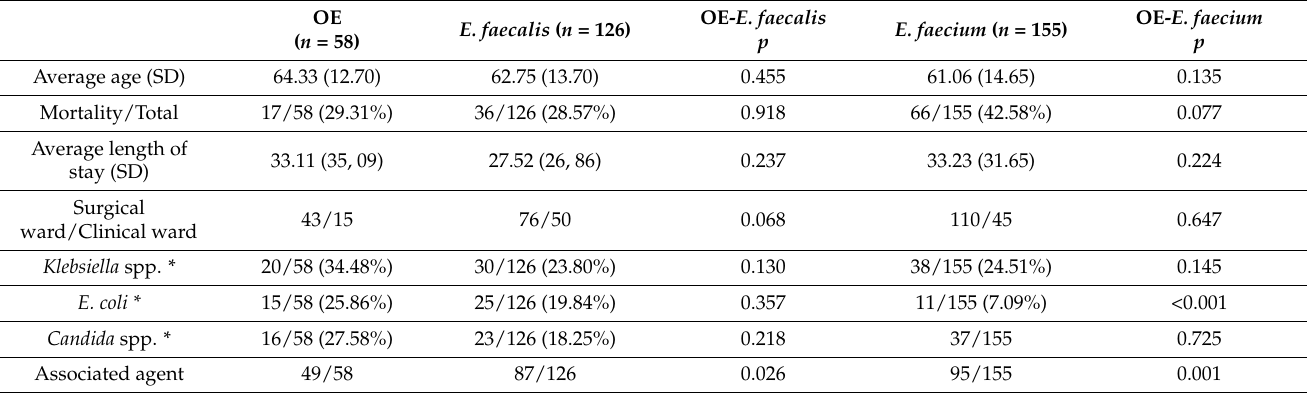
Table 6. Comparison between other Enterococci and E. faecalis and E. faecium .